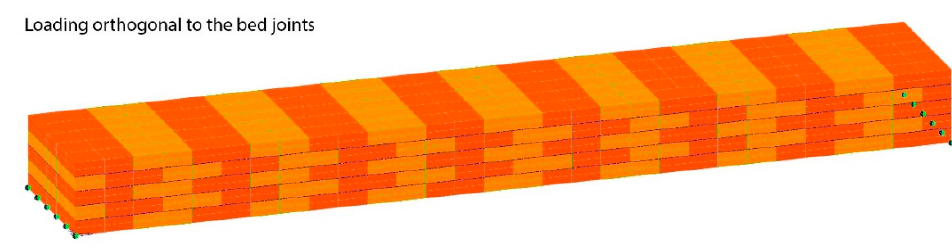
Figure 3. Finite Element Model (FEM): constraints of a beam made by five layers of solid clay bricks 60 mm thick for loading orthogonal to the bed joints.